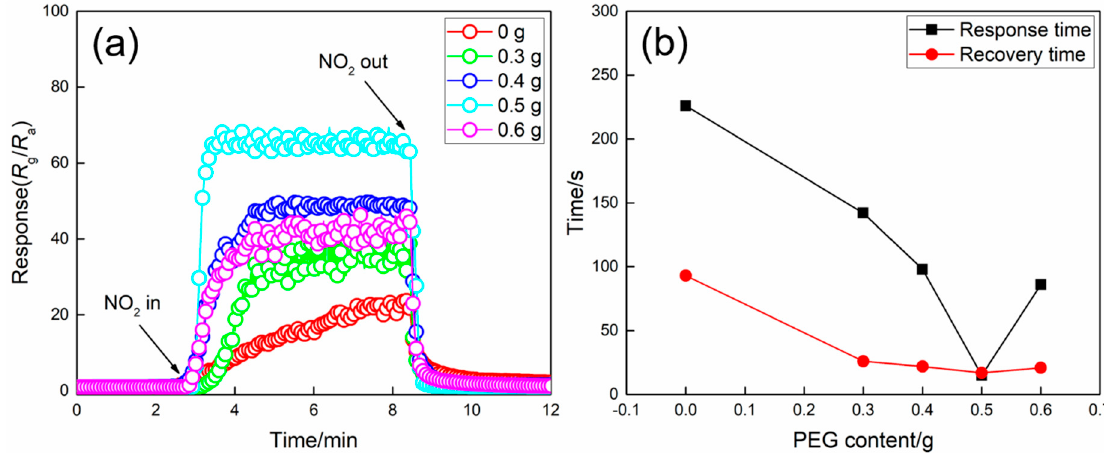
Figure 7. ( a ) Dynamic response/recovery curves and ( b ) response/recovery times of WO 3 films prepared at different PEG contents upon exposure to 5 ppm NO 2 at 100 °C.